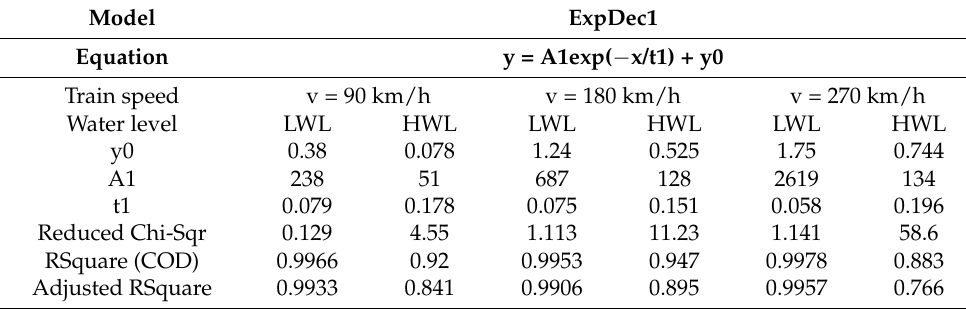
Table 2. Fitting parameters of vibration velocities in horizontal direction.